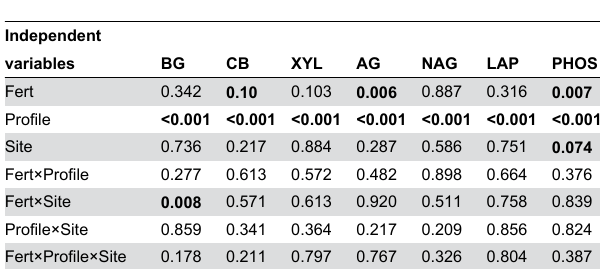
Table 2. Summary of p -values resulting from mixed-effect model analyses for potential enzyme activities assayed at 15 °C.